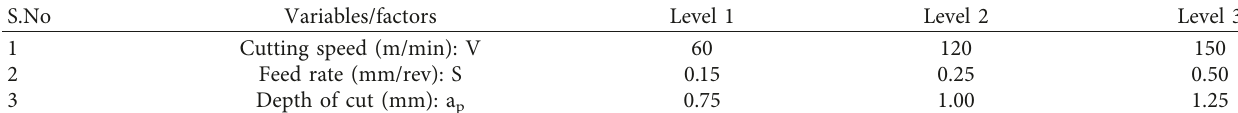
Table 1: Factors for experiments and simulation.